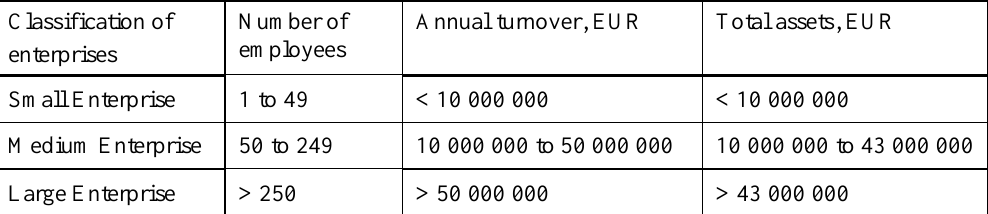
Table 3. Classification of enterprises by size in